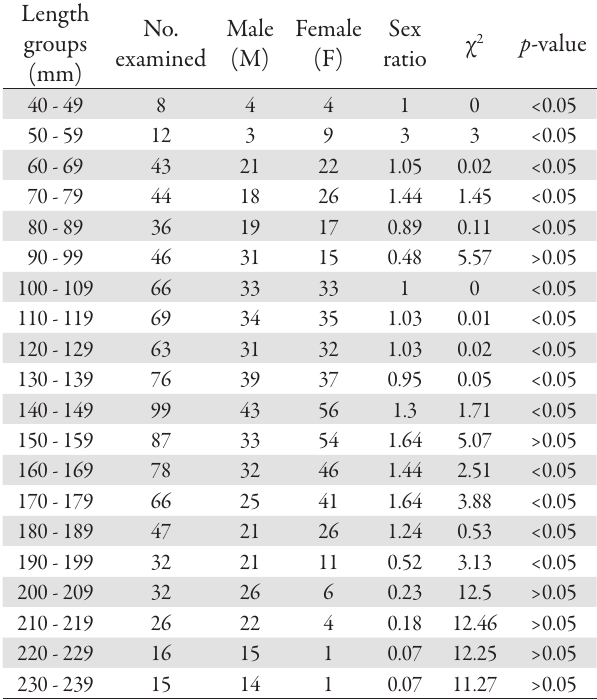
Tab. 2. Sex ratio of S . lessoniana in various length groups Length groups